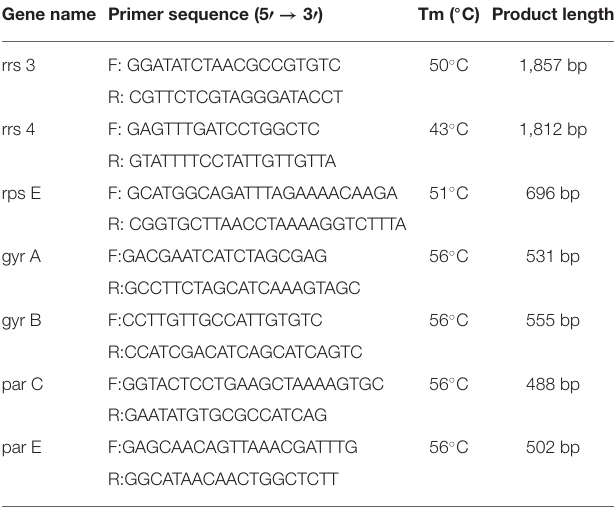
TABLE 1 | Primer sequences.